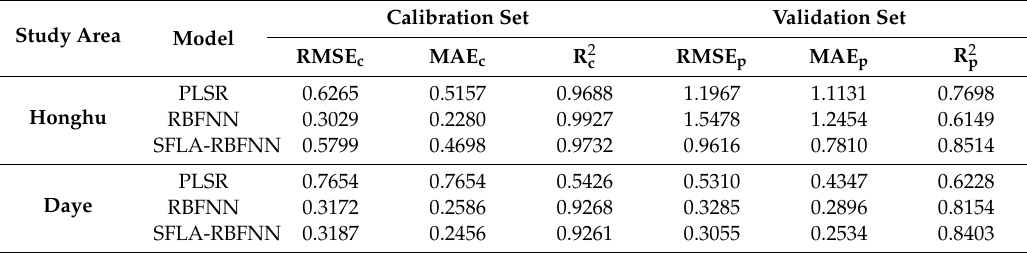
Table 3. Prediction accuracies based on sCARS.